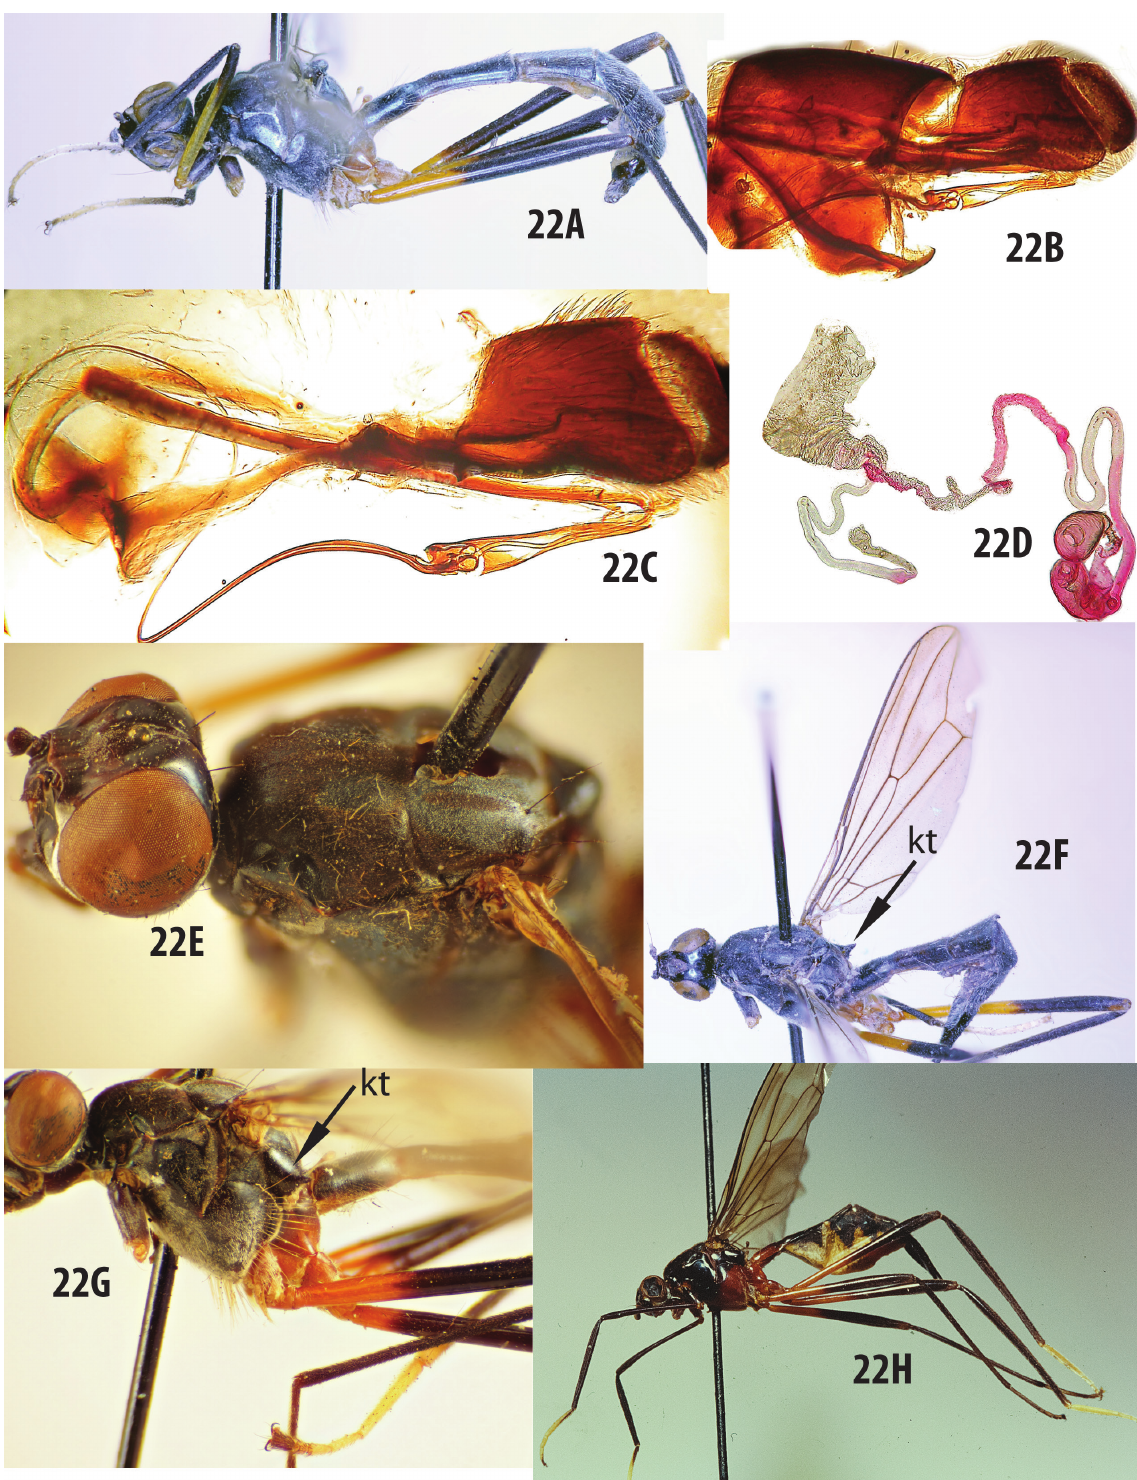
Fig. 22. A–G . Mesoconius albipedis sp. nov . A . Paratype, ♂, BMNH. B . Male terminalia, including segments 6–8. C . Male terminalia, excluding segments 6–8. D . Spermatheca and associated structures. E . Head and thorax, dorsolateral view. F . Holotype, ♀, BMNH, dorsolateral view. G . Holotype, ♀, lateral view. — H . Mesoconius albimanus Enderlein, 1992, lectotype, ♀, MNBG. Abbreviation: kt =